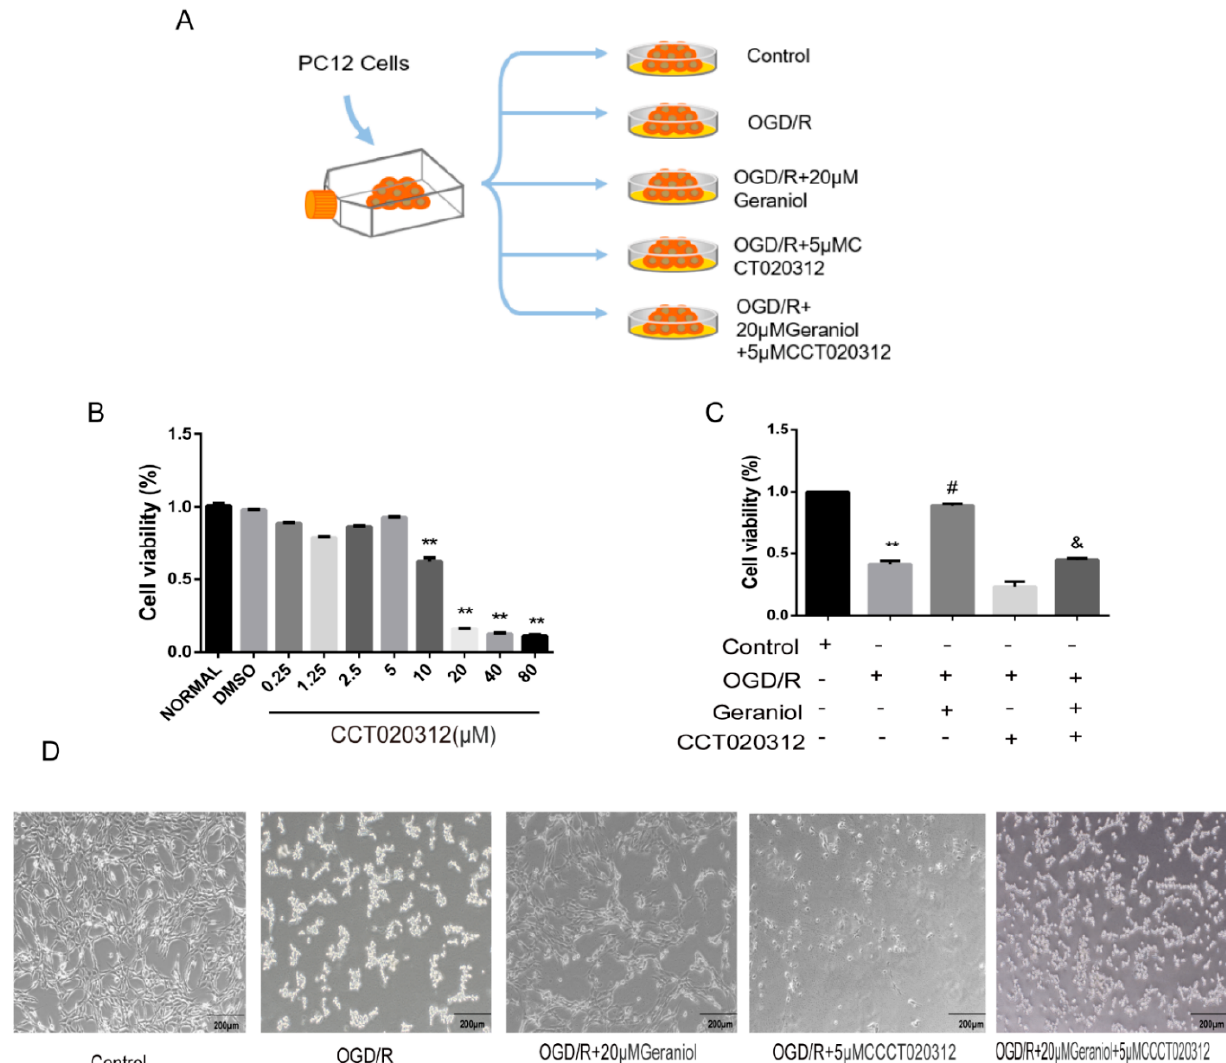
Figure 9. Geraniol had a protective effect on PC12 cells induced by OGD/R through the PERK-ATF4- CHOP signaling pathway in vitro. ( A ) Cell experiment grouping. ( B , C ) Cell viability was assayed using a CCK-8 kit ( n = 3). ( D ) Microscopic observation of the morphology of OGD/R-induced PC12 cells. ( B ) ** p < 0.01 CCT020312 group vs. normal group, ( C ) ** p < 0.01 OGD/R group vs. control group, # p < 0.01 OGD/R+20 µ M geraniol group vs. OGD/R group, & p < 0.01 OGD/R + 20 µ M geraniol + 5 µ M CCT020312 vs. OGD/R + 20 µ M geraniol